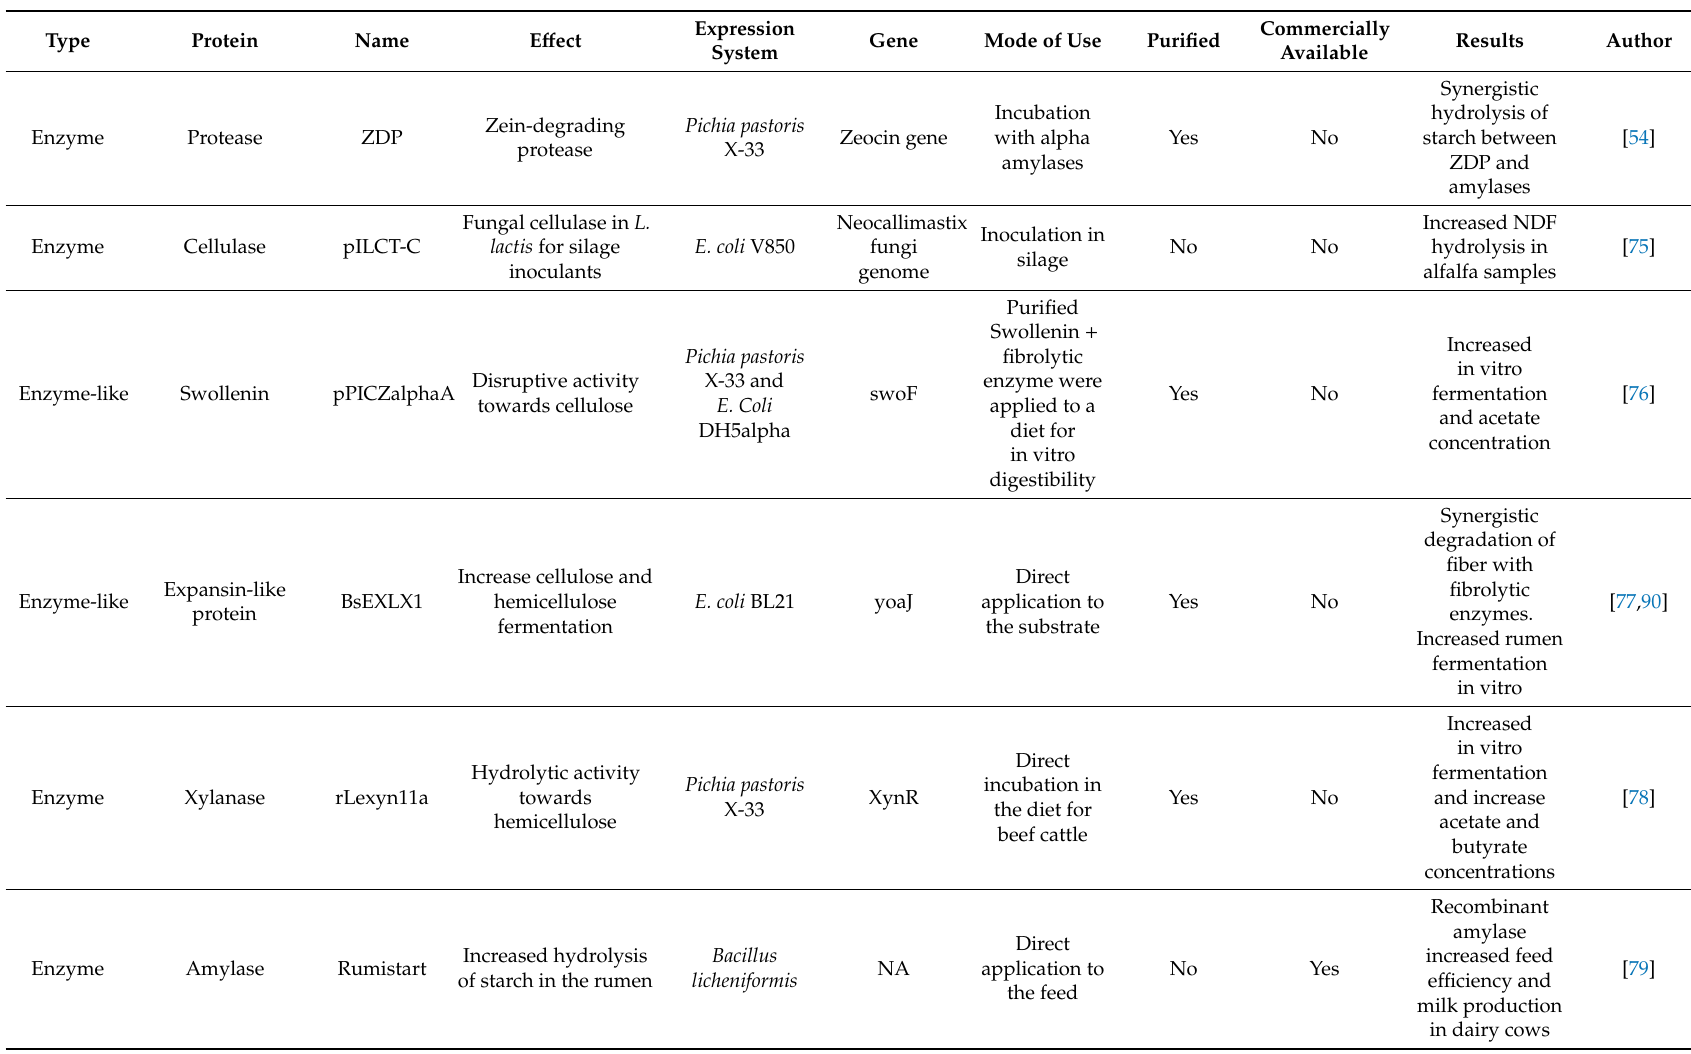
Table 3. Summary of e ff ects of recombinant enzymes on in vitro and in vivo fermentation and performance of